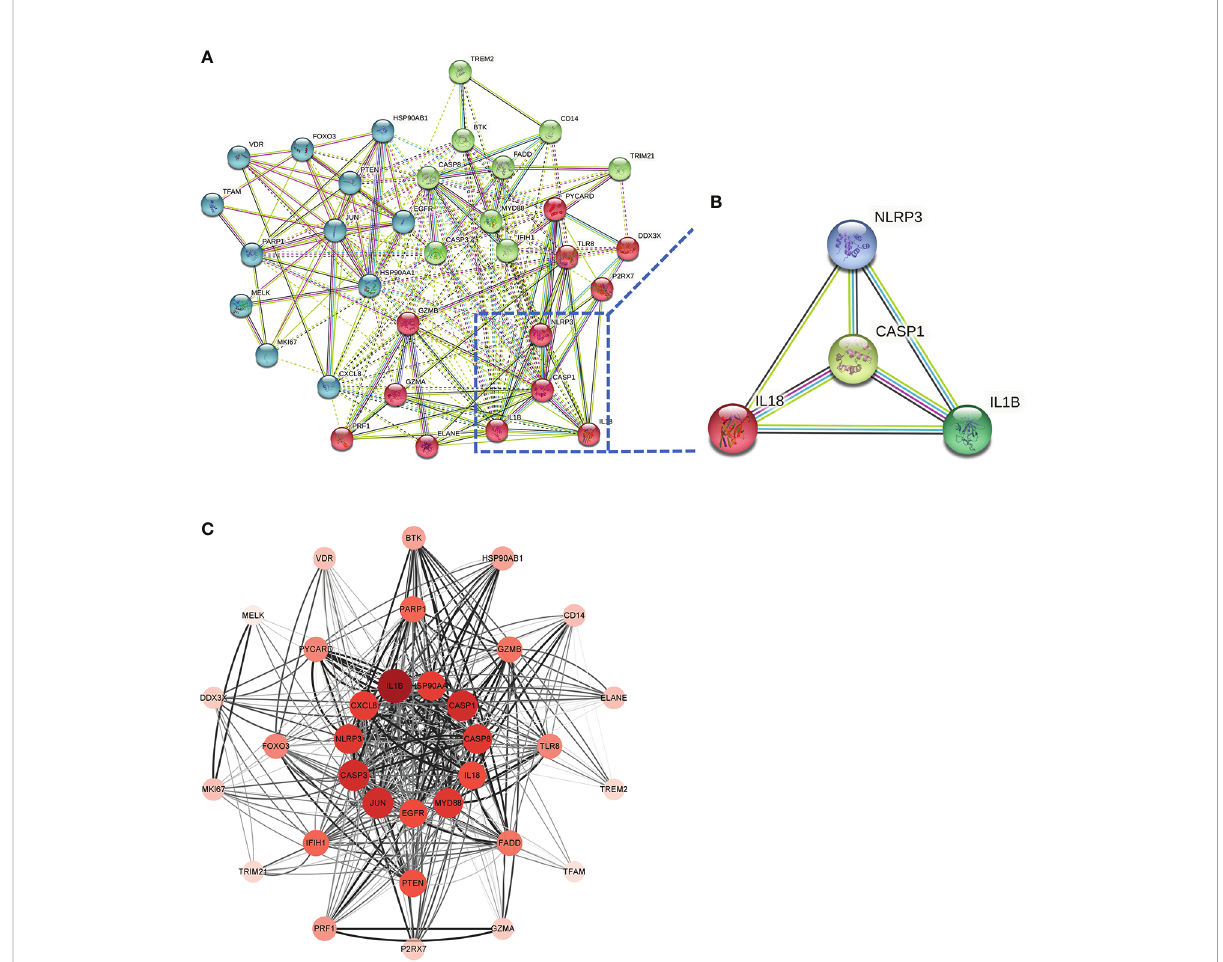
FIGURE 6 Screening Hub genes. (A) PPI network diagram obtained after applying the k-means algorithm based on machine learning to the Co-genes. The four genes in the lower right-hand corner of the enlarged diagram are CASP1, NLRP3, IL1B, and IL18. (B) PPI network diagram after processing with Cytoscape software. (C) The Top 11 hub genes are fi ltered using the Degree algorithm under the CytoHubba package